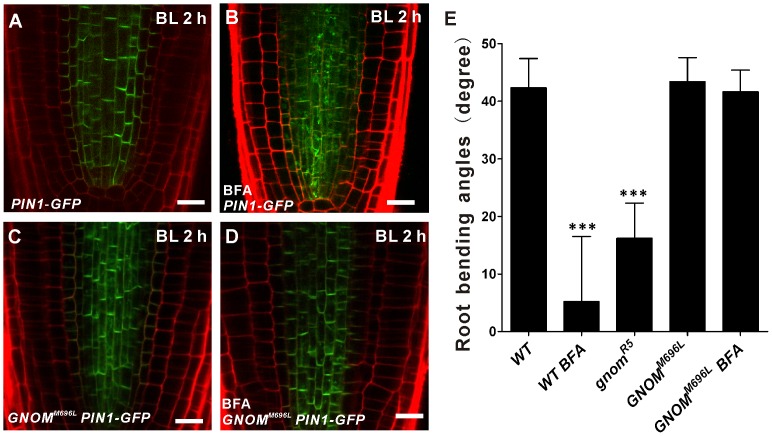
Involvement of the BFA-sensitive, GNOM-dependent trafficking pathway in blue-light-induced PIN1 distribution.(A–D) PIN1 localization, as revealed by GFP fluorescence, was examined in the steles of PIN1::PIN1-GFP (A or C) and PIN1::PIN1-GFP GNOMM696L (B or D) seedlings treated or not with BFA and exposed to unilateral blue light for 2 h. Four-day-old etiolated seedlings were pretreated with DMSO as a control or BFA (50 µM) in the dark for 1 h, and subsequently exposed to unilateral blue light illumination (10 µmol m−2sec−1) for 2 h. At least twelve seedlings were imaged per line for each of three replicates. Arrows indicate blue light direction. Bars = 10 µm. (E) Root bending angles under BFA treatment. The bending angles of the roots away from the vertical direction were measured after 48 h unilateral blue light illumination and average curvatures were calculated. Values are the average of three biological replicates (n >10 per time point on each replicate). Error bars represent SE and *** indicate significant difference at P<0.001, as determined by Student’s t-test.